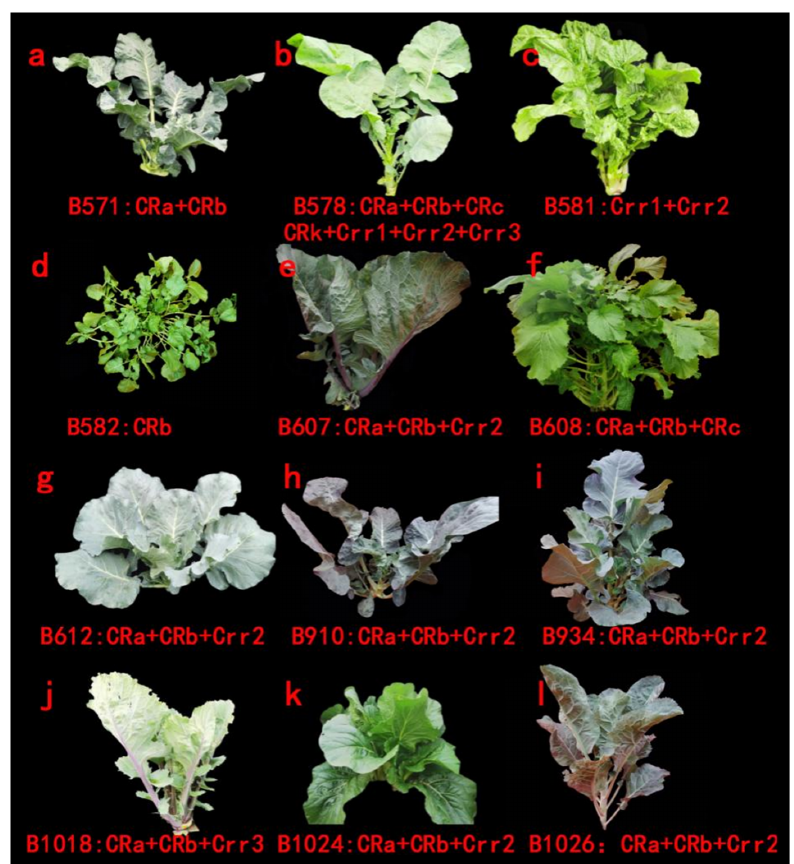
Figure 2. Species-aggregated multiple resistance sites. ( a – l ) letters represented experimental materials of B571, B578, B581, B582, B607, B608, B612, B910, B934, B1018, B1024, and B1026, respectively.